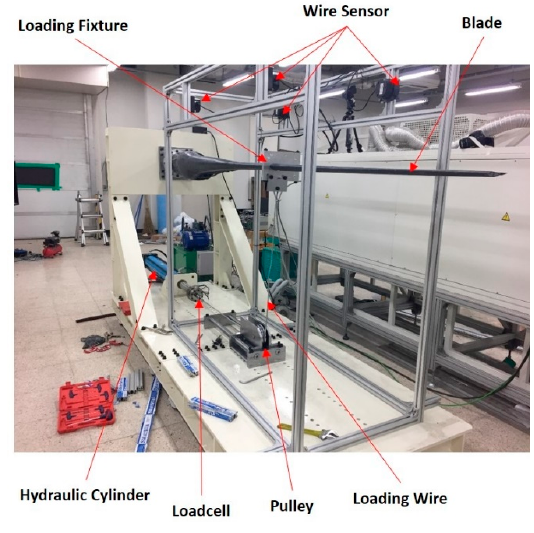
Figure 17. The test setup.